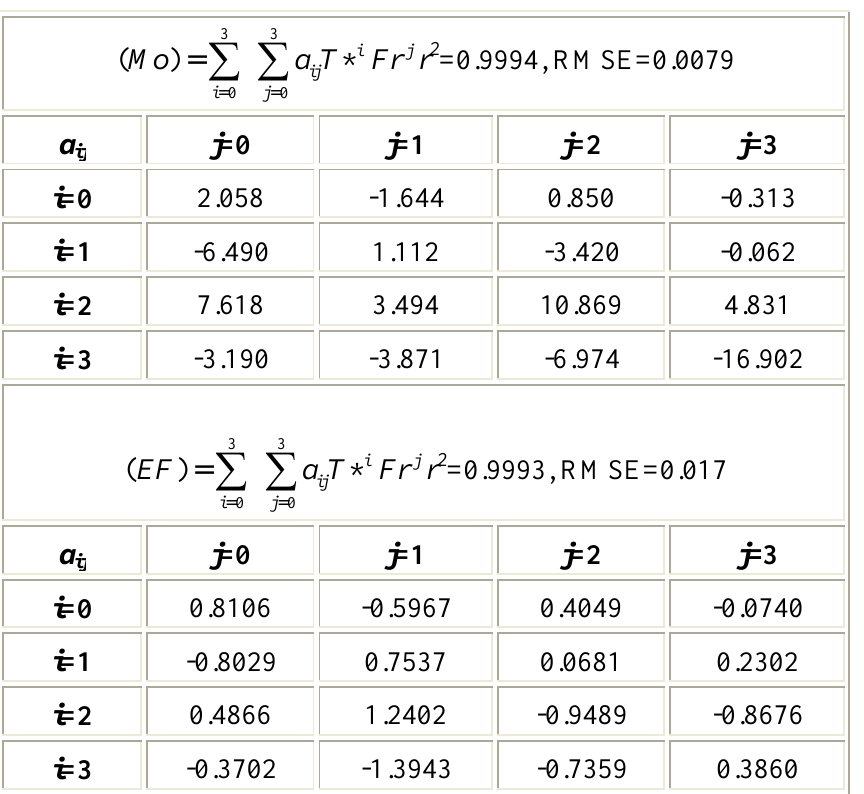
Table 1. Coefficients of the polynomial relationship for Mo (a; top) and EF (b; bottom) between T* and Fr as specified in Equation 3.